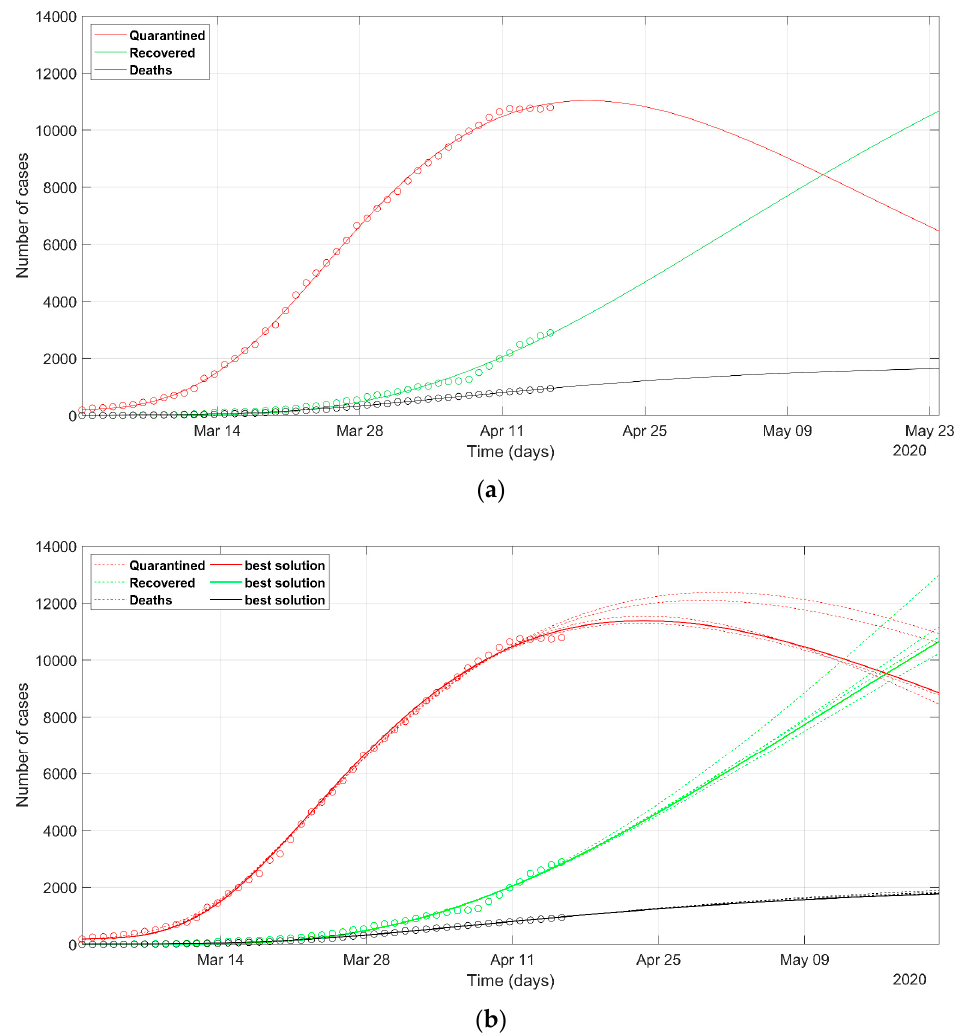
Figure 5. Observed data ( circles ) of quarantined ( red ), recovered ( green ), and deaths ( black ) for Veneto region, updated on 15 April 2020. The continuous lines refer to the predicted evolution in 30 days according to the SEIR model solved with ( a ) deterministic approach, ( b ) stochastic approach. In ( b ) the solid line refers to the best PSO solution, the dashed lines refer to the most probable solutions (i.e., the solutions within 5% of the minimum NRMSE).